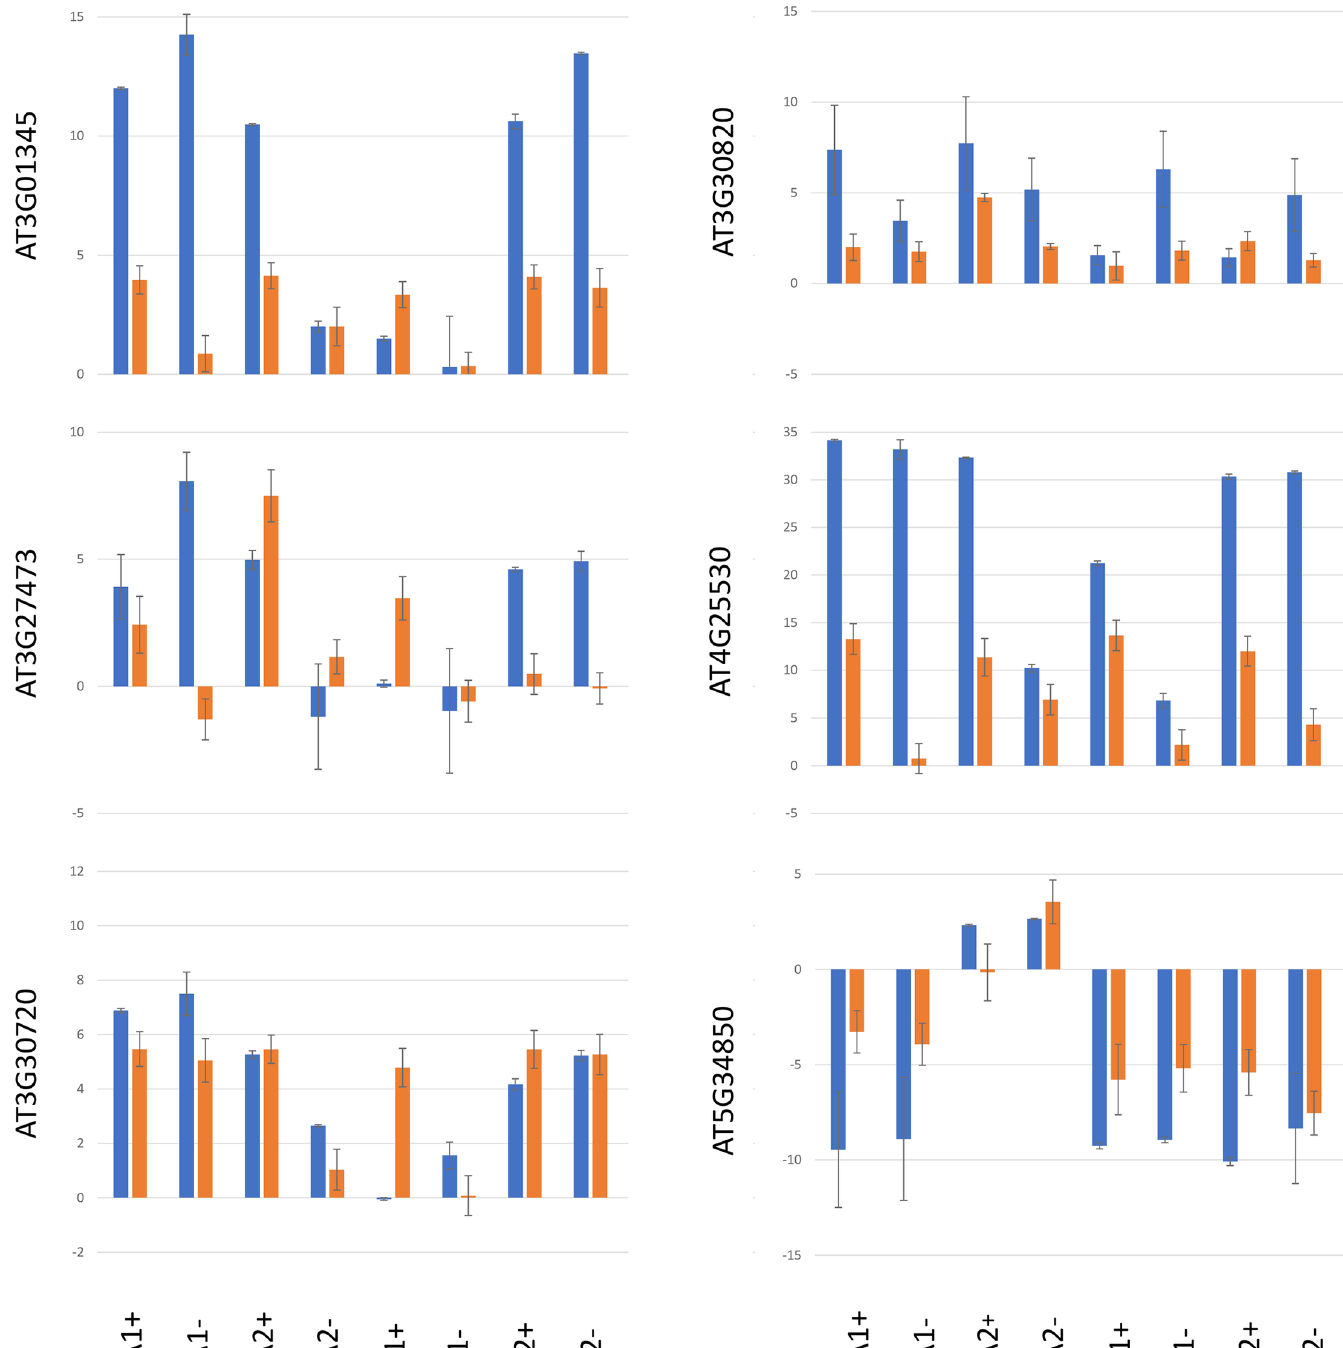
Fig 5. Comparison of expression profiles of genes AT3G01345 , AT3G27473 , AT3G30720 , AT3G30820 , AT4G25530 and AT5G34850 in MET1 lines. T3 seeds are labelled in blue, T4 seeds are labelled in orange.